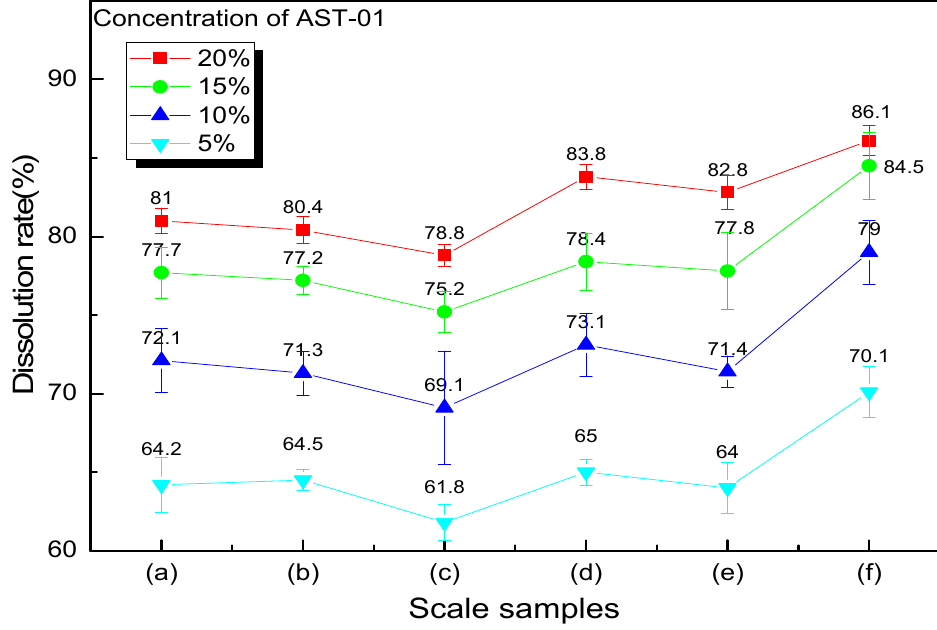
Figure 7. Descaling effect of different acid concentrations on six scale samples.